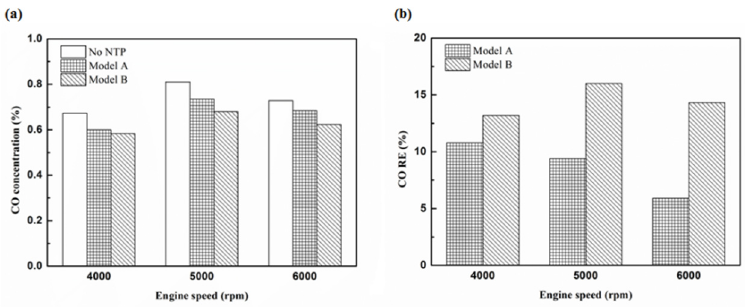
Figure 16. The CO ( a ) emission values and ( b ) RE of control voltage 5 V using platinum.